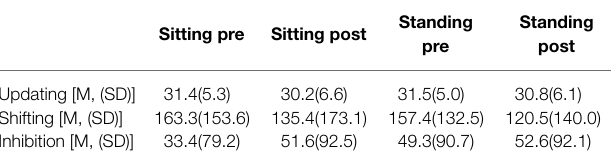
M, Mean; SD, Standard